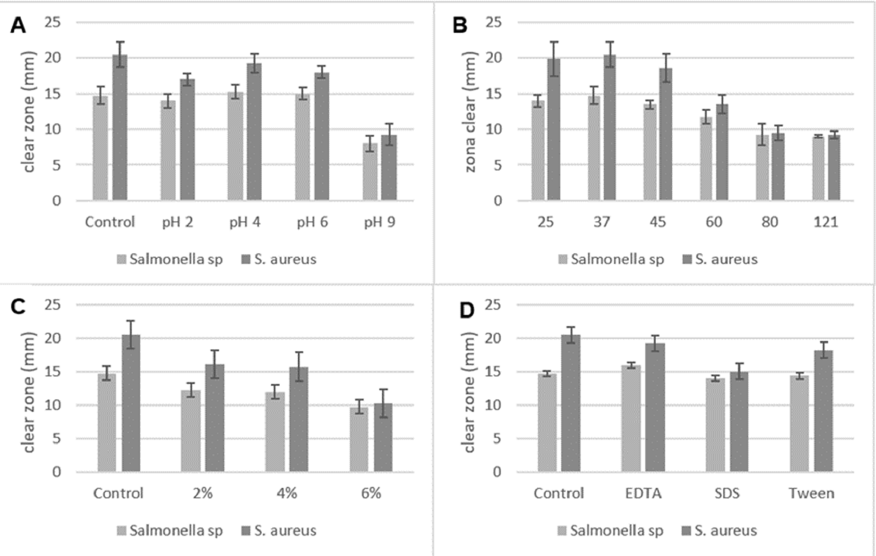
Figure 5. Partial characterization of the isolated antibacterial substance. ( A ) Effect of pH: the stability of the antibacterial substance at various pH values was measured after mixing the antibacterial substance with different pH values (2.0, 4.0, 6.0, and 9.0). ( B ) Effect of temperature: the antibacterial activity substance was heated at 25, 37, 45, 60, and 80 °C for 30 min, and at 121 °C for 15 min. ( C ) Antimicrobial activity with different salt concentrations (2%, 4%, 6%). ( D ) Antimicrobial activity with additional surfactant (EDTA, SDS, and Tween 80).